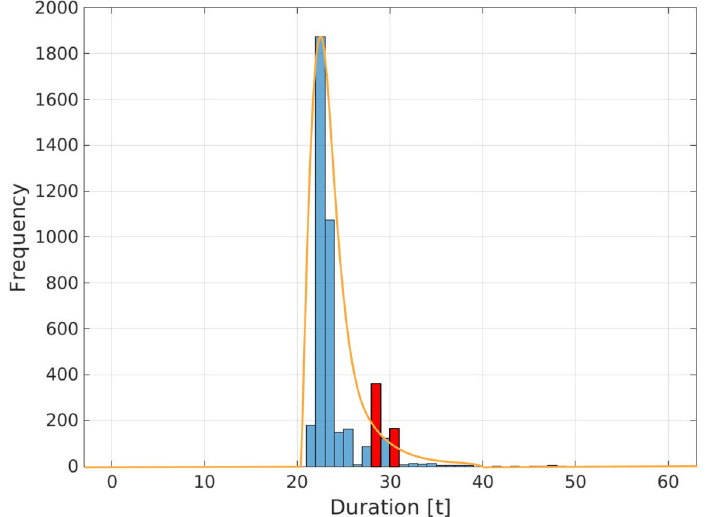
Figure 2. Peak detection in a histogram of durations for a specific action utilizing MLE as a threshold, based on data from a real-world car production dataset recorded by Volkswagen Commercial Vehicles. Peaks above the MLE threshold (red) are considered as significant errors.